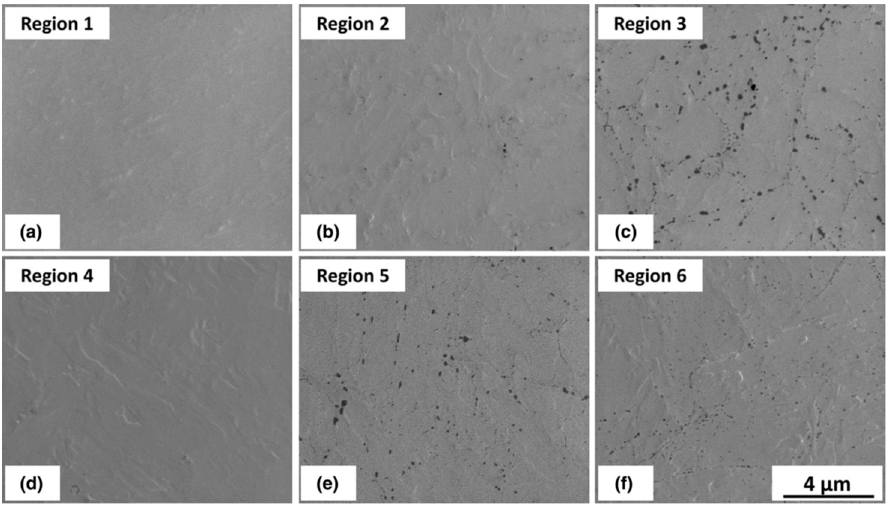
Figure 7. Ion-beam-induced secondary electron micrographs ( a – f ) showing the secondary precipitate particles in the HAZ.